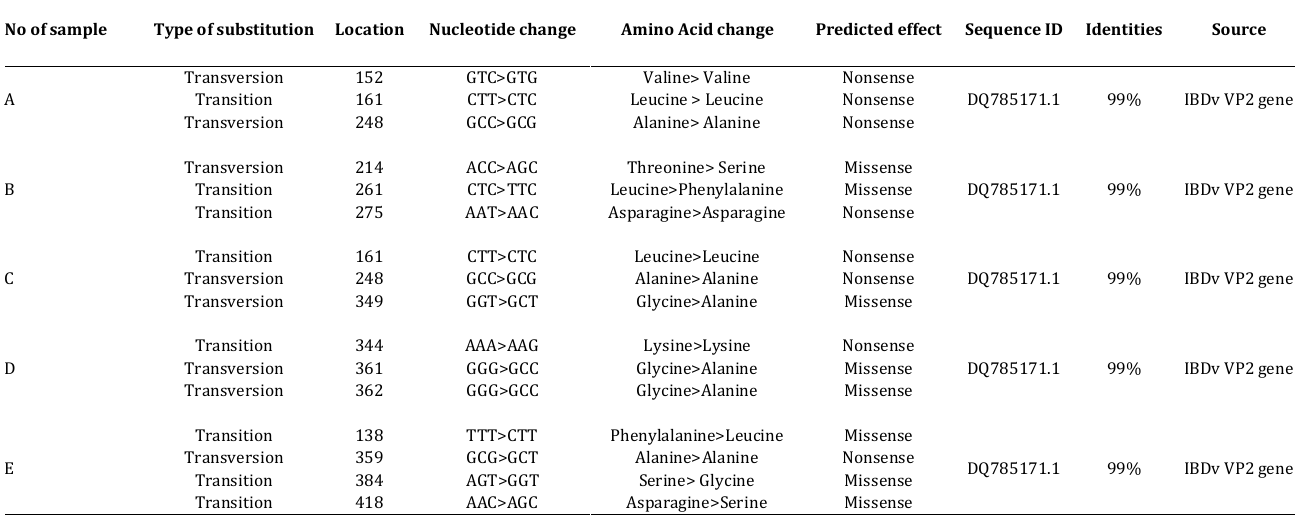
Table 2. Transitions and transversions of nucleotide change percentage of VP2 fragment